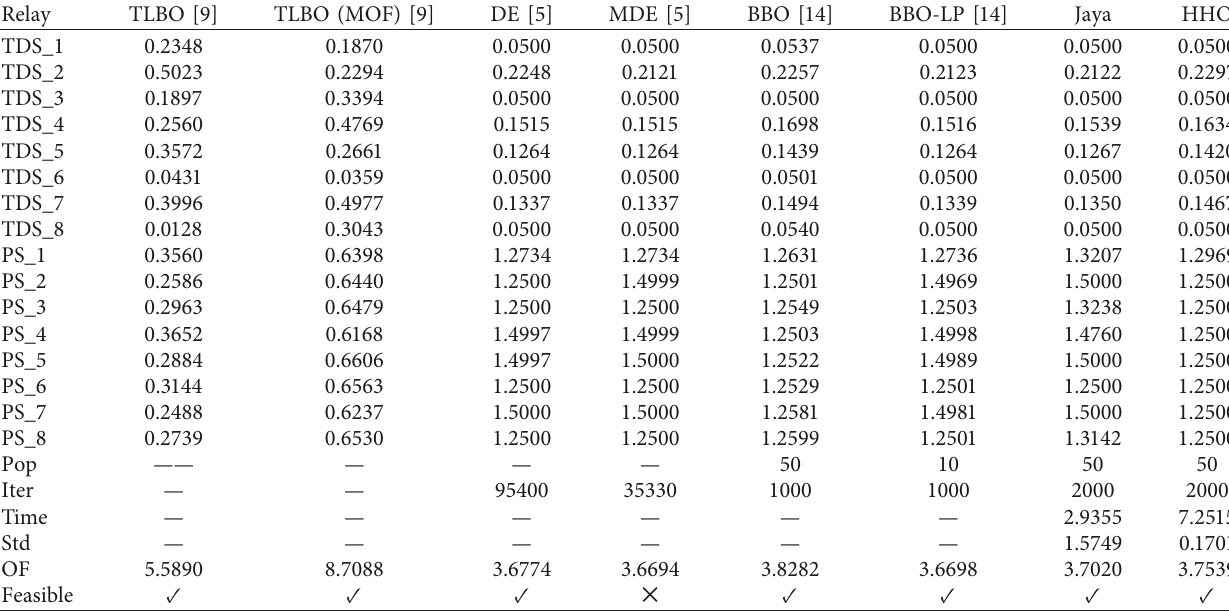
Table 19: Time dial setting and pickup current for the 4-bus system by NLP